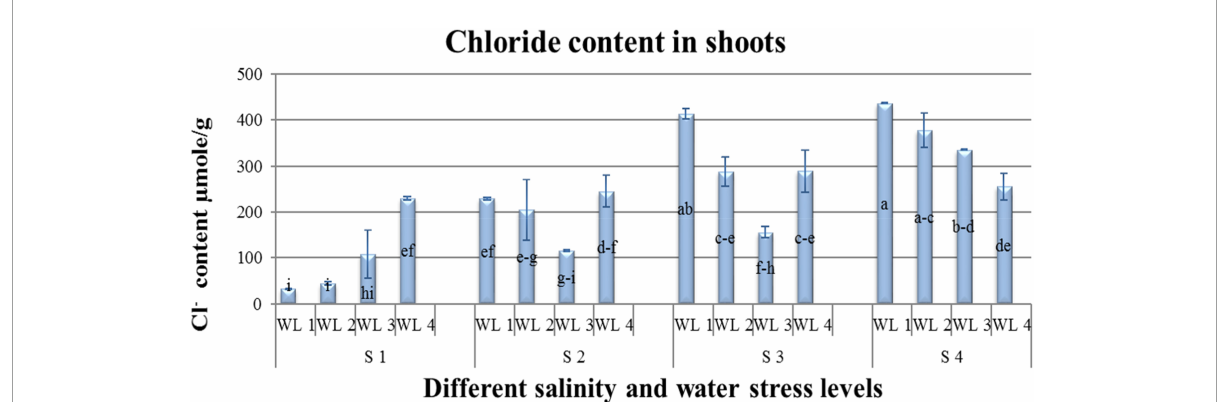
FIGURE4 Interactive effect of salinity and drought stress on Cl − content of Atriplex leucoclada . Error bars represent the standard error of the mean ( n = 3). WL stands for water level (WL1 = 100% field capacity, WL2 = 80% field capacity, WL3 = 60% field capacity and WL4 = 40% field capacity)